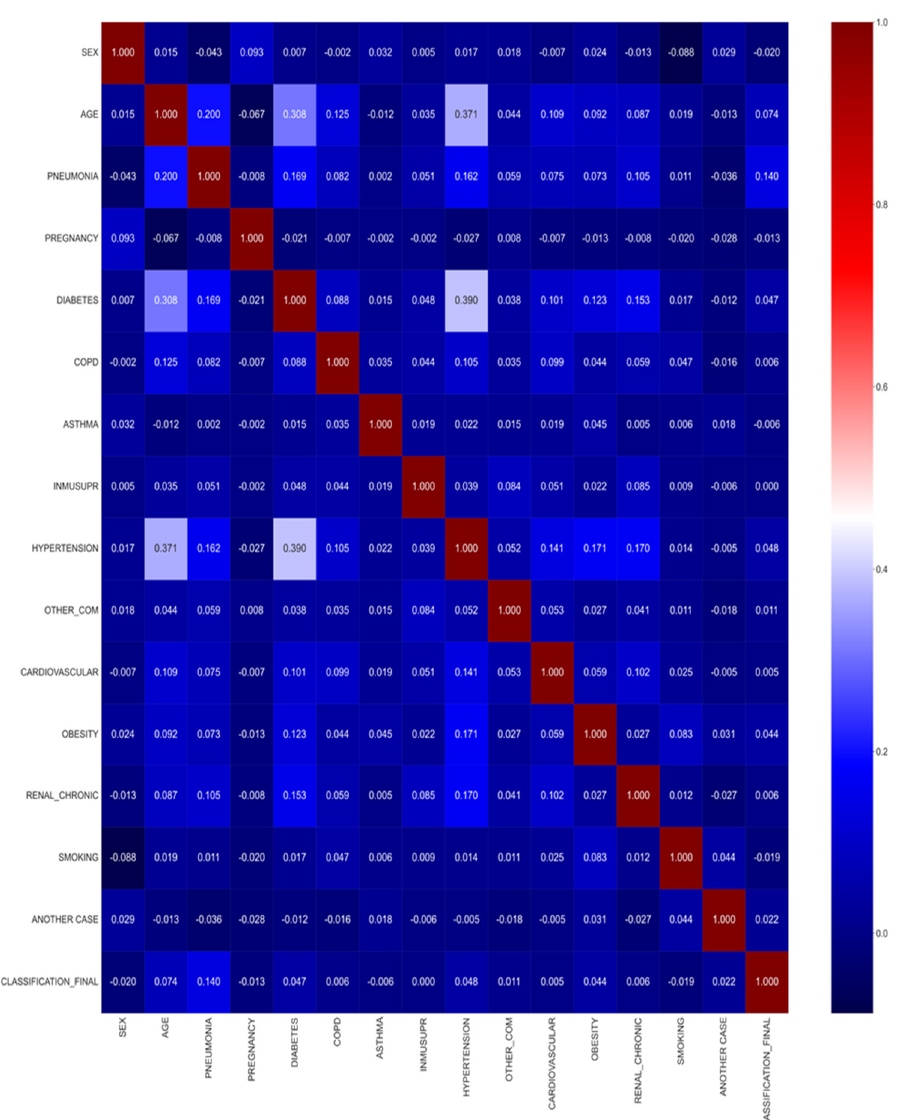
Figure 2. Pearson’s correlation matrix which indicates the strength of the relationship among vari- ables.